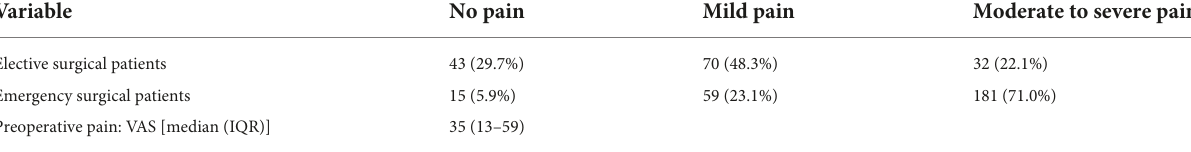
TABLE 4 Preoperative pain among surgical patients, N = 400. Variable No pain Mild pain Elective surgical